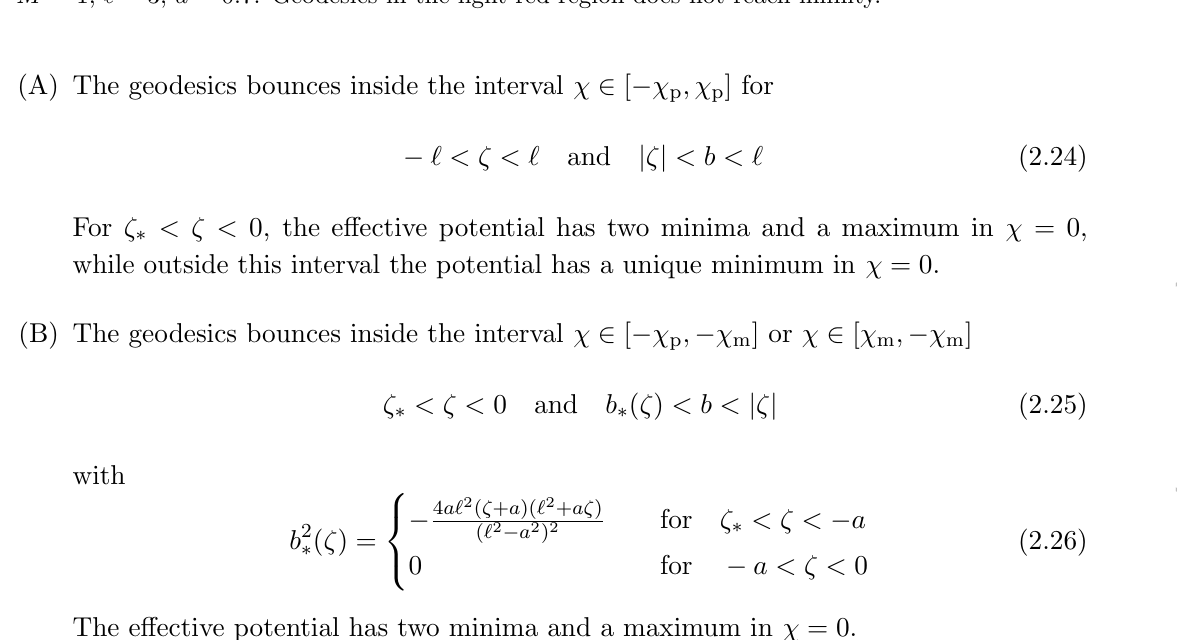
Figure 2. Allowed regions (green, red and light red) in the (cid:16) , b plane of a BH with parameters: M = 1, ‘ = 3, a = 0 : 7. Geodesics in the light red region does not reach